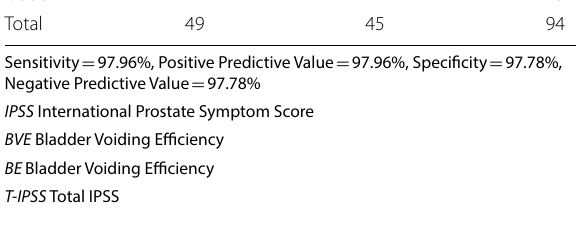
Fig. 1 The Pearson’s correlation coefficient ( R ) for this relationship as shown by the Scatter Plot was